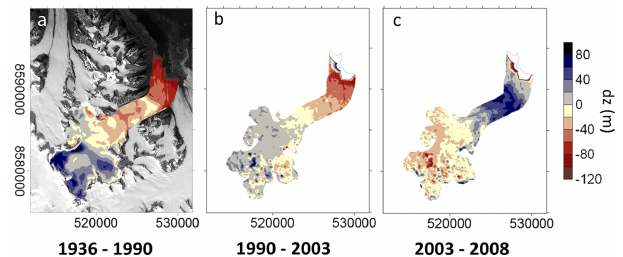
Fig. 3. Surface elevation changes on Zawadzkibreen flowing from SW to NE. (a) Build-up in the upper part; thinning and retreat in the lower part. (b) Surge stage 1: initial lowering in SE basins. (c) Surge stage 2 at the transition to stage 3: lowering of the entire upper part and aggregated thickening in the lower part. Note that the lower- most terminus has not yet advanced and is still undergoing thinning and retreat, and also that some of the areas with the heaviest accu- mulation correspond to the areas with initial lowering. Background image by SPOT SPIRIT 2008 ©